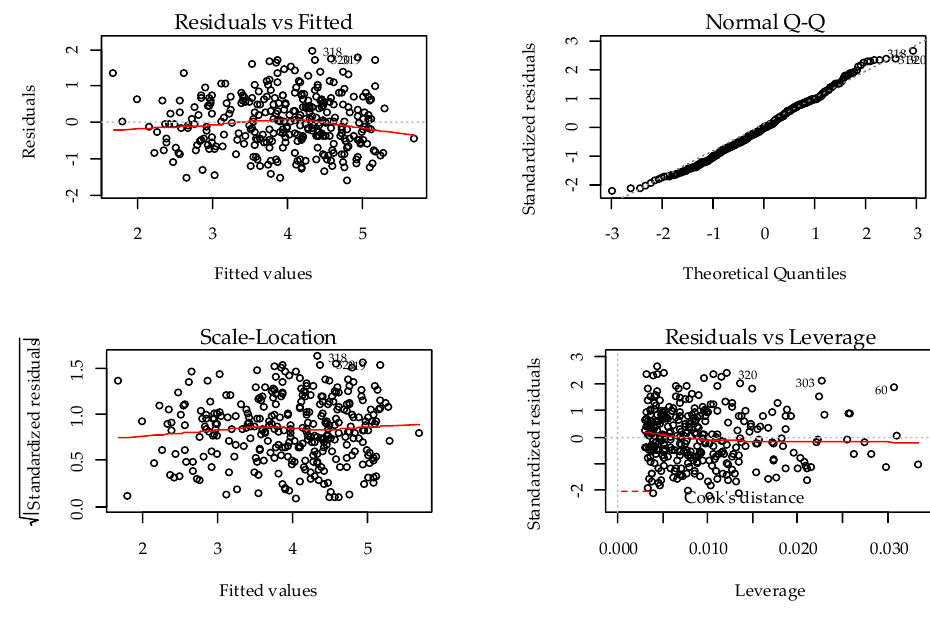
Figure 7. Plot training results of the MLR model.